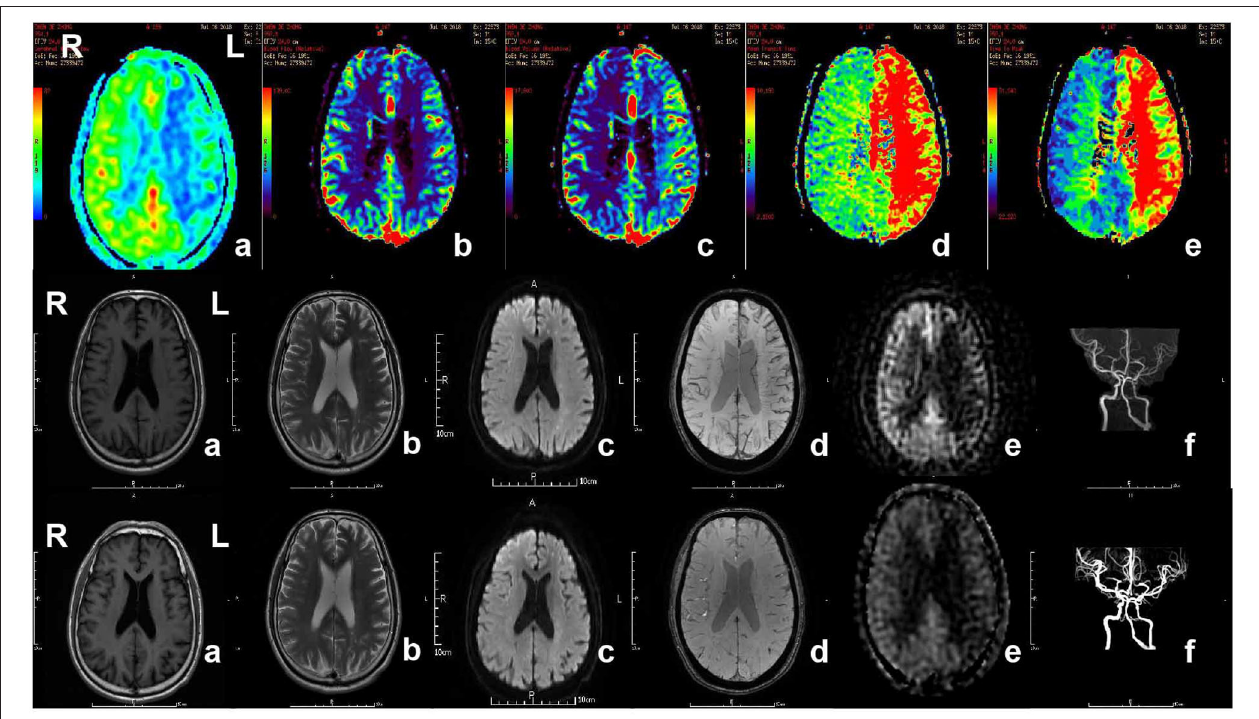
FIGURE 3 | MR imaging of the patient with acute ischemic stroke. The patient, 71-year-old male, suffered from weakness of right limbs, alalia and was unable to walk 3h prior to the imaging. Medical history included hypertension, diabetes and varicosity of both lower extremities. Physical examination showed right facial paralysis, the muscle strength of right limbs was grade I, right Babinski sign ( + ), Chaddock sigh ( + ), and NIHSS score was 13. The diagnosis of the patient is acute ischemic stroke. The patient was given multimodal MRI and MRA before and after recanalization. The first row showed perfusion-weighted imaging. a and b, Lower CBF in left cerebral hemisphere. c, Higher CBV in left cerebral hemisphere. d, Longer MTT in left cerebral hemisphere. e, Longer TTP in left cerebral hemisphere. The second row and third row showed MRI and MRA before recanalization and after recanalization, respectively. a, b, and c, In the left frontal lobe and lateral ventricle had sporadic dots with slightly longer T1 signal, longer T2 signal higher signal, respectively, in T1WI, T2WI, DWI. d, No cerebral microbleeds in SWI. e, Original ASL. f, MRA showed the intracranial segment of the left internal carotid artery and the left middle cerebral artery were significantly narrow in the second row, while recanalization got in left internal carotid artery and middle cerebral artery. MR, magnetic resonance; MRA, magnetic resonance angiography; SWI, susceptibility weighted imaging; ASL, arterial spin labeling; CBV, cerebral blood volume; CBF, cerebral blood flow; TTP, time to peak; MTT, mean transit